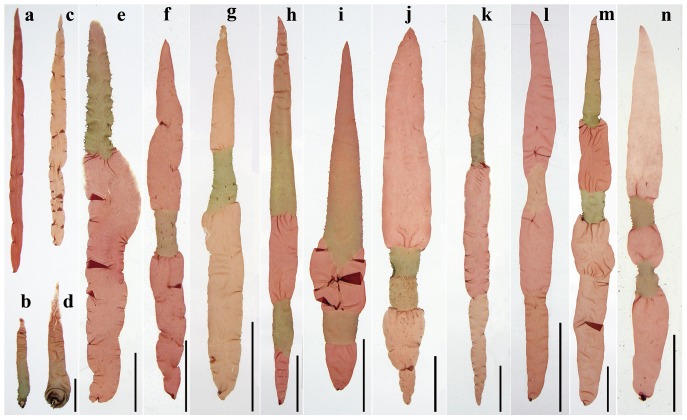
Macrophotographs of F1 gametophytic blades developed from conchospores released from heterozygous conchocelis in the cross between a red mutant (R,♀) and the wild type (W,♂) of Pyropia haitanensis.
a–d. Single-colored blades: a. A red (R) blade; b. A wild-type (W) blade; c. A near- red (R′) blade; d. A near-wild-type (W′) blade; e–l. Color-sectored blades with 2–4 sectors: e. R+W; f. R+W′+R; g. R′+W+R′; h. R+W+R+W; i. R+W′+R+W′; j. R′+W′+W+R; k. R′+R+W+W′; l. R′+R+R′+R (without paternal color); m-n. Color-sectored blade with 5 sectors: m. R′+R+W+R+W; n. R+W′+R+W′+R′. The color phenotypes are shown from the base to the tip of a blade. a–d are the same magnification. Scale bars: 1 cm in a–i and k–m, and 0.5 cm in j and n.